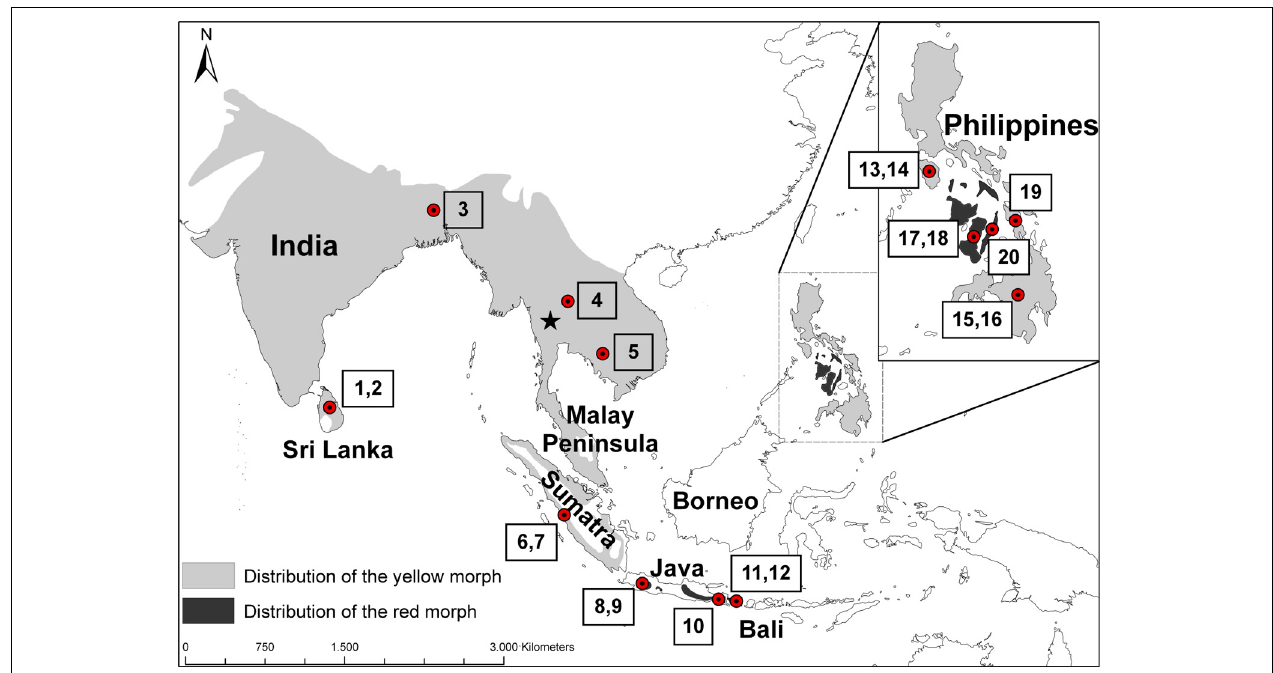
FIGURE 1 | Distribution of the coppersmith barbet ( Megalaima haemacephala ). Light gray indicates the distribution of yellow morphs and dark gray the red morphs, based on (Short and Horne, 2001). Dots indicate approximate origin of the specimens studied and the numbers correspond to